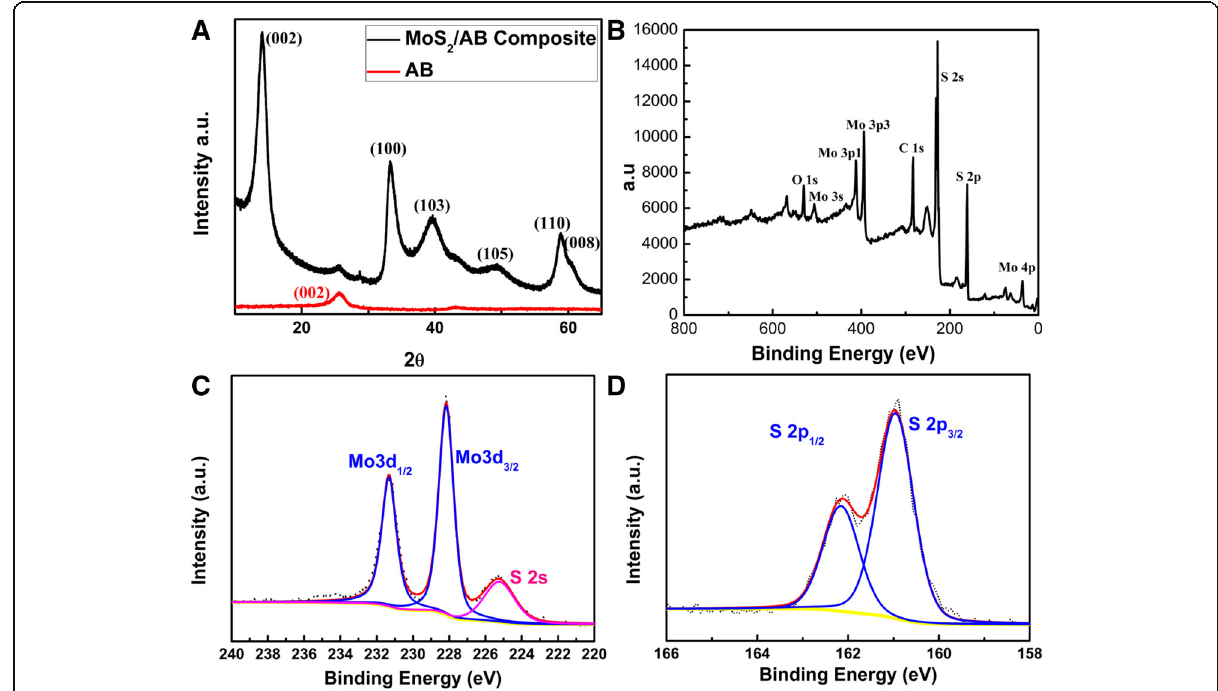
Fig. 1 ( a ) XRD diffraction patterns for MoS 2 /AB and raw AB. ( b ) XPS survey spectrum showing the presence of Mo, S, C, and O. c High-resolution spectra of Mo 3d peak and d S